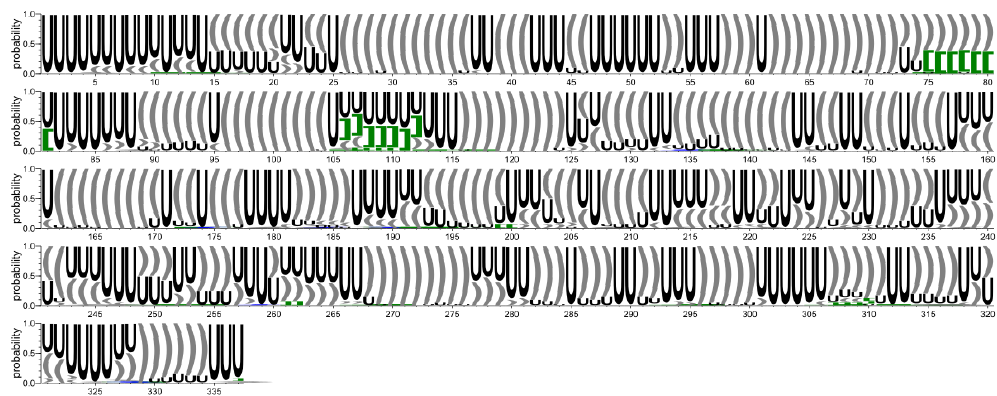
Figure 7. Secondary structure conservation diagram for the 3 (cid:48) -UTR region. ‘U’ corresponds to unpaired residue. According to the DBL representation of the secondary structure topology [50], square brackets [ ] (green) represent pseudoknots of the first order, and curly brackets { } (blue) represent the second order